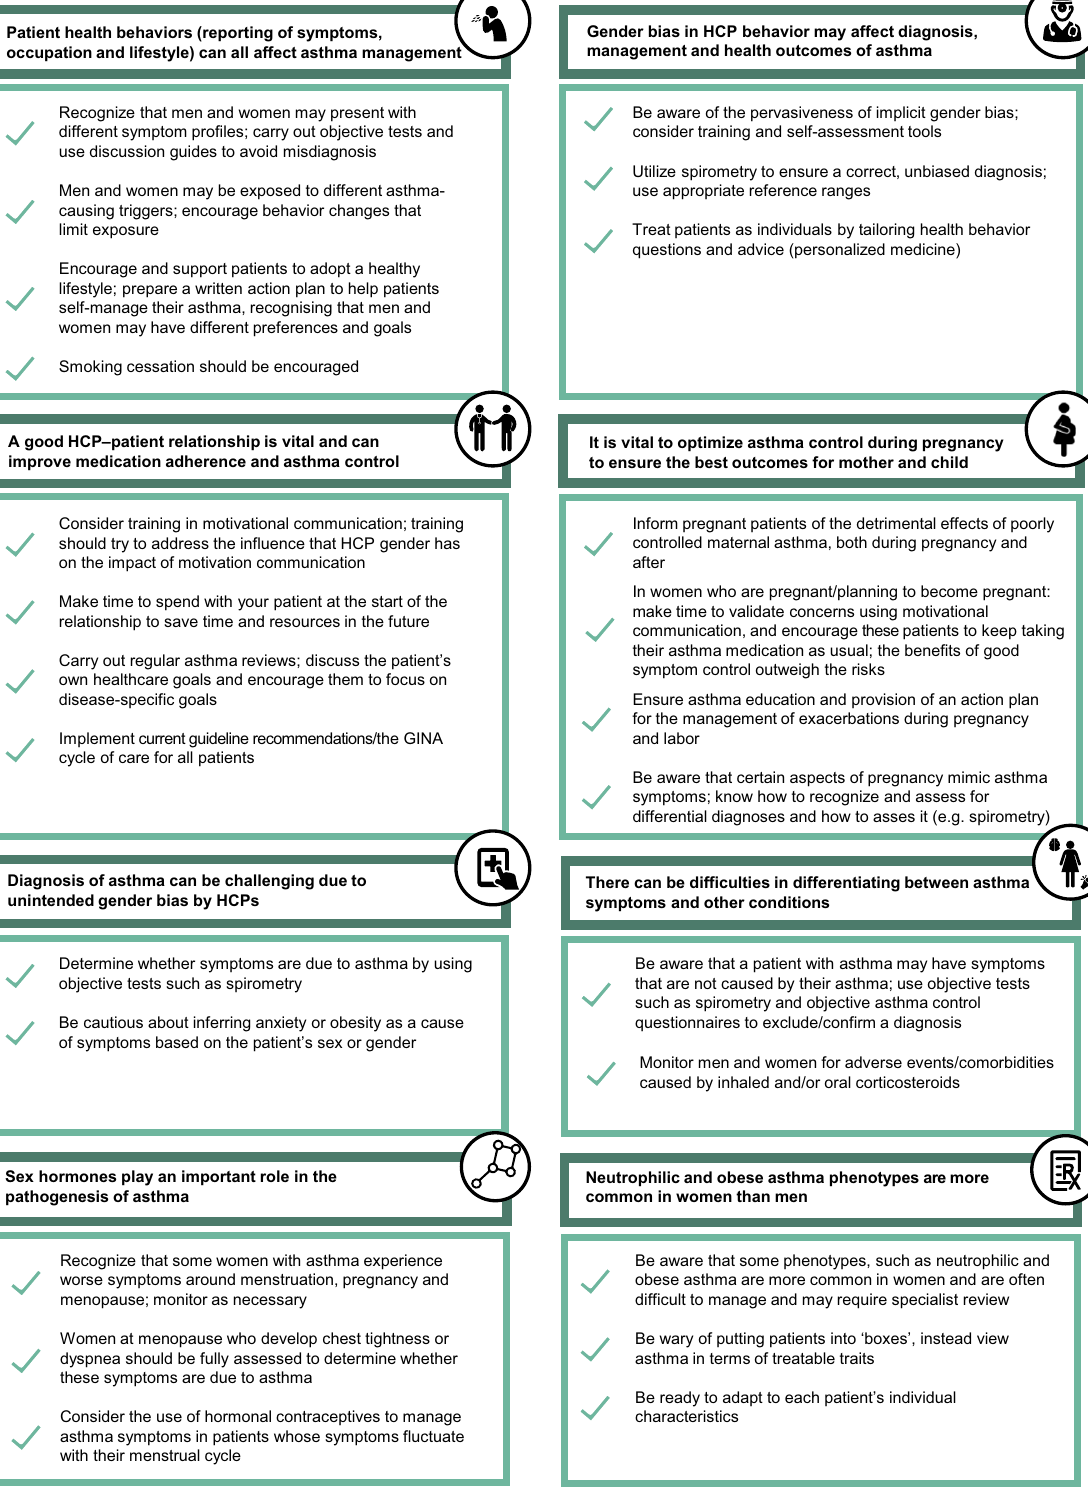
Fig. 4 Summary: Suggested actions to minimize the impact of sex and gender differences in asthma diagnosis and management. GINA Global Initiative for Asthma, HCP healthcare